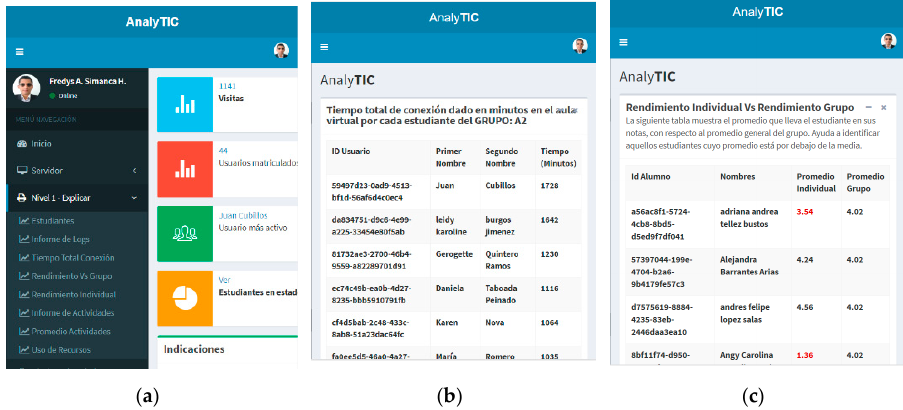
Figure 3. Risk assessment matrix.